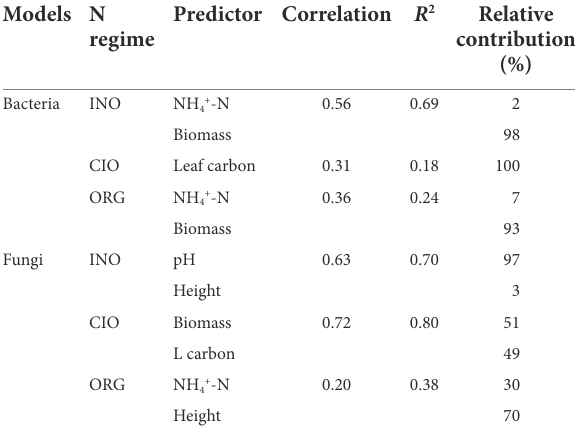
TABLE 2 The best predictors and relative contribution to soil bacterial and fungal richness. Models N Predictor Correlation R regime